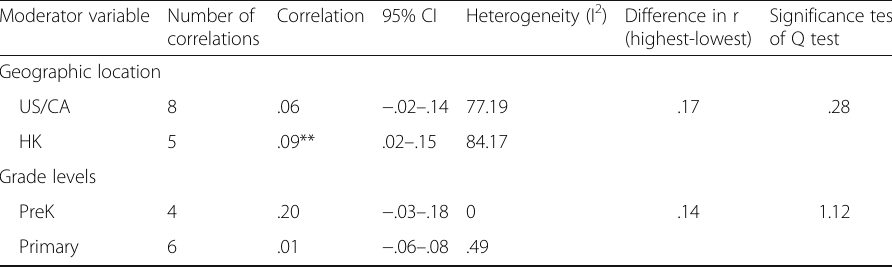
Table 3 Number of correlations, correlation, 95% confidence interval, heterogeneity statistics, difference in r between categories and significance test of categories for moderators of the relationship between Chinese and English vocabulary Moderator variable Number of Correlation 95% correlations